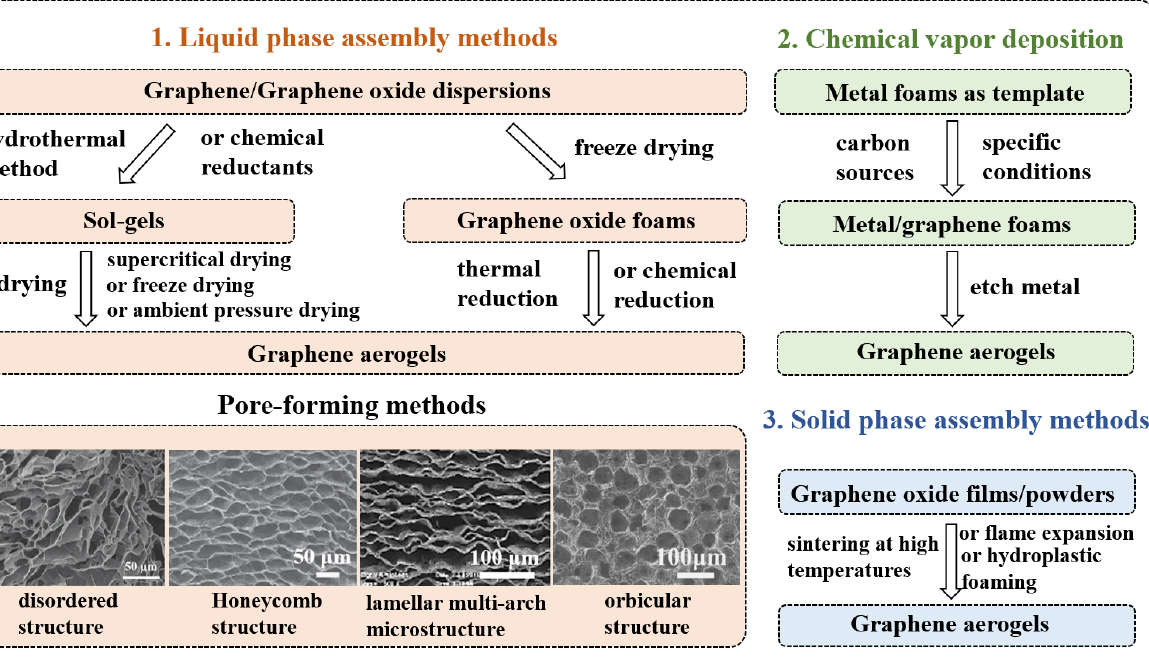
Figure 3. Preparation methods summary of polymer foams.